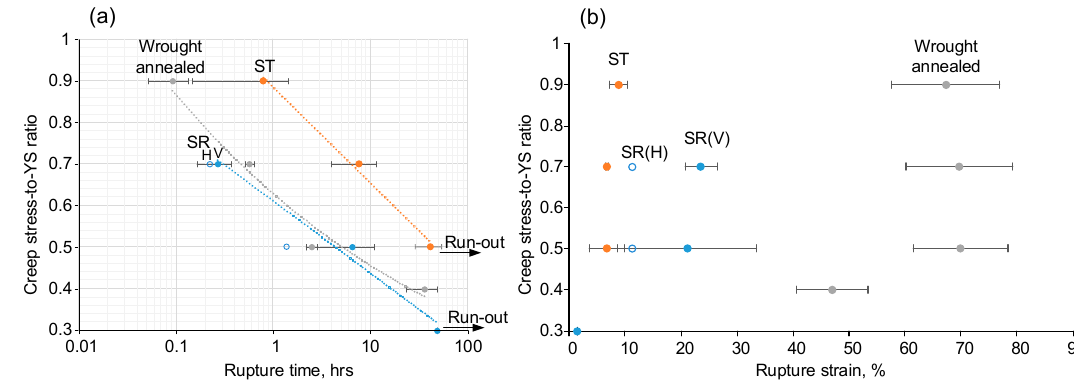
Figure 8. Applied stress in relative values ( σ / YS) as a function of the ( a ) creep rupture time and ( b ) rupture strain for the SR, ST, and wrought annealed IN625 alloy (760 °C).